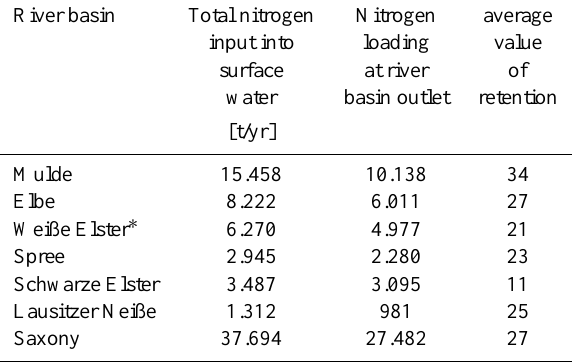
Fig. 1. Nitrogen retention in rivers and reservoirs per surface water body.